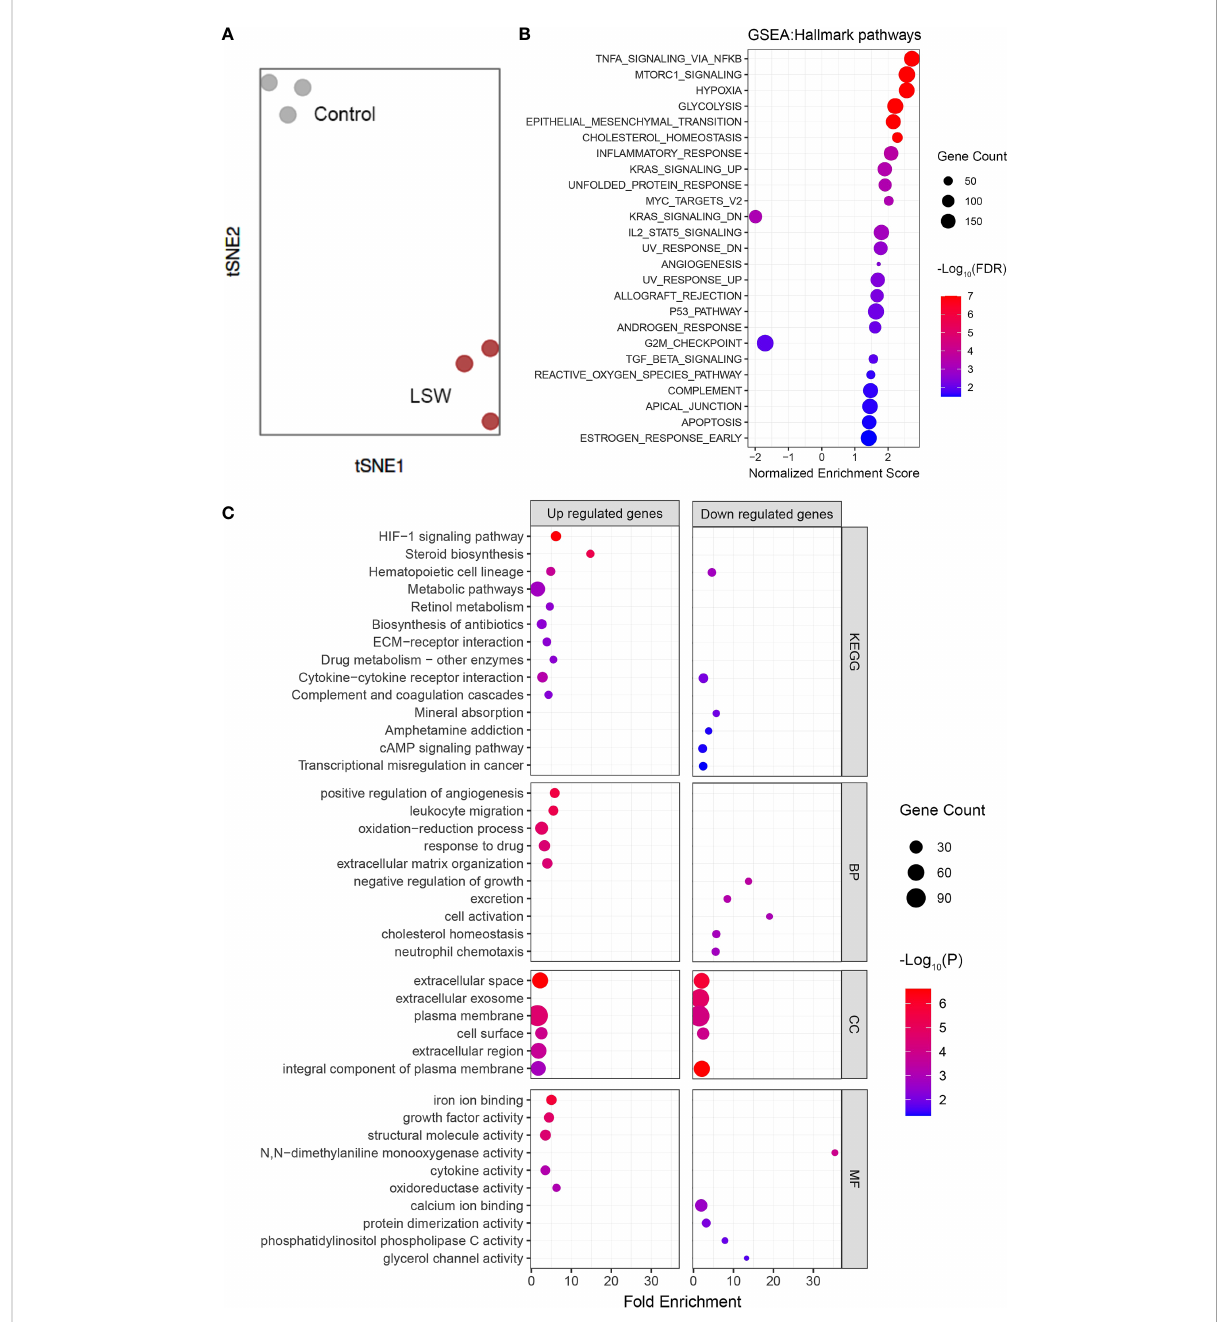
FIGURE 2 Global transcriptomic changes in MDA-MB-468 cells exposed to bioactive extracts from Limonium Sinense . MDA-MB-468 cells were treated with or without Limonium Sinense water extracts (LSW, 500 m g/ml) for 48 hours followed by RNA-Seq. (A) t-distributed stochastic neighbor embedding (tSNE) plot showing a clear sample separation for control vs. LSW-treated MDA-MB-468 cells (n=3 samples per group). (B) Scatter plot showing Gene Set Enrichment Analysis (GSEA) in MDA-MB-468 cells treated with LSW. The sizes of circles represent gene count, and the colours of circles represent the -Log10 of the false discovery rate (FDR) values. (C) Scatter plot showing enriched Kyoto Encyclopedia of Genes and Genomes (KEGG) and Gene Ontology (GO) terms from 3 categories (BP, biological process; CC, cellular component; and MF, molecular function) in MDA-MB-468 cells treated with LSW. The sizes of circles represent gene counts, and the colours of circles represent the -Log 10 of the P